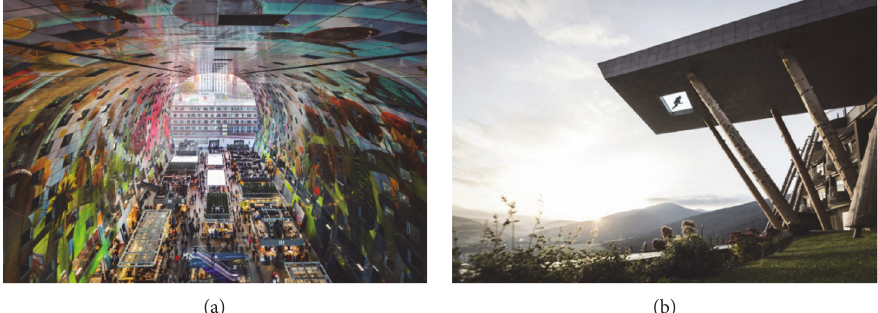
Figure 13: Static input items with good match of NEG (or POS) and HR variation: (a) Markthal, Rotterdam, NL (© MVRDV); (b) Hubertus Hotel (Valdaora, IT, © Design & Contract). (a) Item #19; (b) item #24.